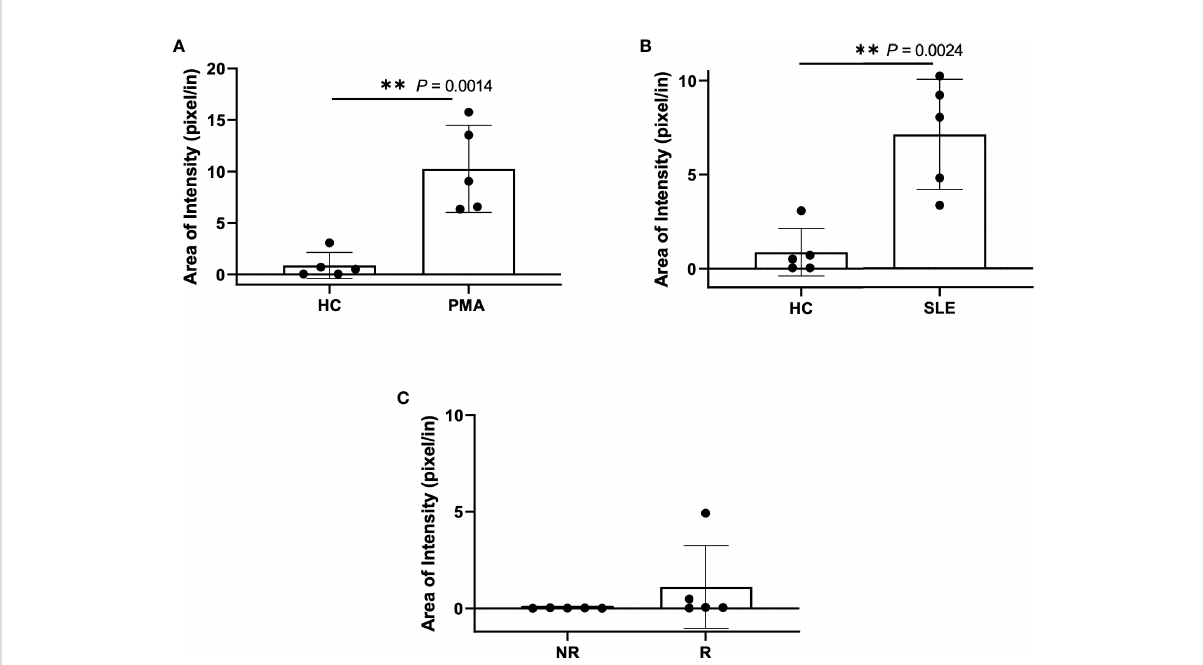
FIGURE 6 Plasma smear quanti fi cation using 20x objective and average threshold-area pixel intensity. Using ImageJ, representative plasma smear images were converted to 8-bit grayscale images and pixel intensity threshold range was set from 40-255. Images were measured and averages of threshold-area pixel intensity were computed for (A) healthy control and PMA stimulated (n=5), (B) healthy control and SLE (n=5), and (C) GaP risk and non-risk (n=5). Observed differences between sample groups correlate to previously calculated NET quantity in ELISA. Data are presented as mean ± SD. P values are reported after unpaired parametric T test was performed.